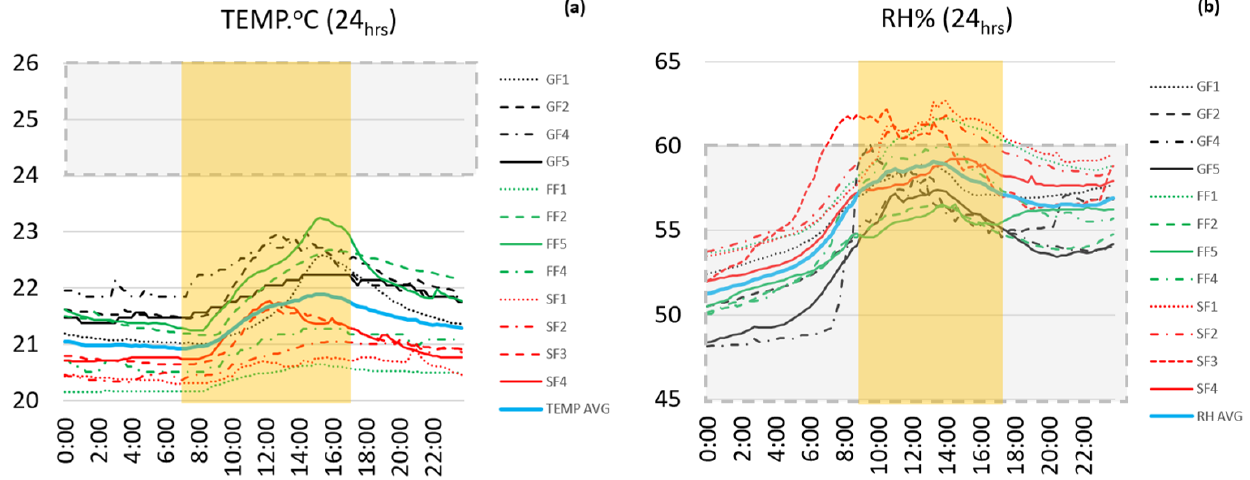
Figure 4. Temperature ( a ) and RH ( b ) 1-day (24 h) profiles. The blue line indicates total readings ‘average, the yellow box denotes working hours, and the grey box indicates recommended thresh- olds.